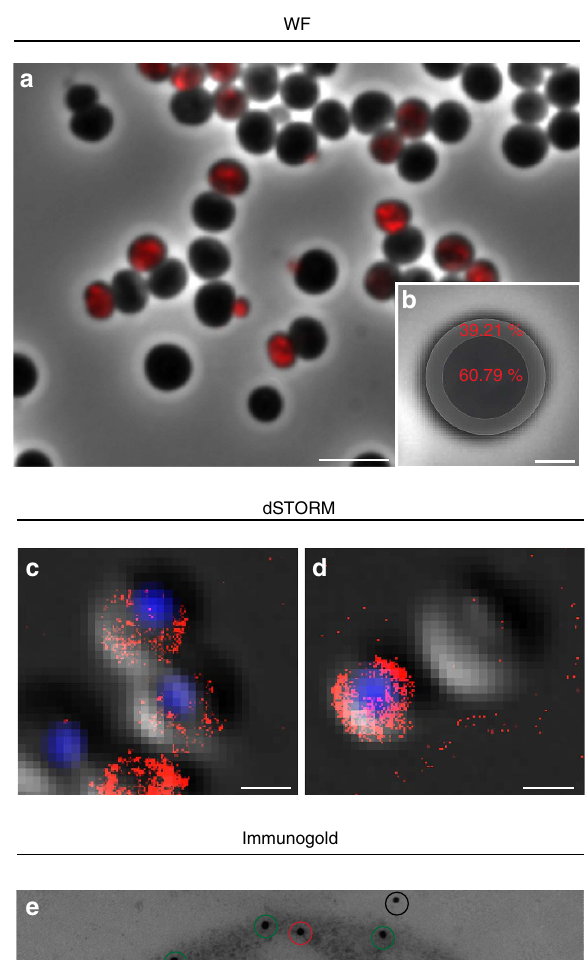
Figure 4 | The innermost planctomycetal membrane is energized. ( a ) Overlay of the wide field (WF) fluorescence signal from a representative ATPase localization experiment (red, anti-Na þ -F1F0-ATPase antibody) with the corresponding phase contrast (phaco) micrograph of G. obscuriglobus cells. Scale bar, 5 m m. ( b ) Among 50 analysed cells in five fields of view, 39.21% of the fluorescence signals were detected in the outer rim, as indicated by the schematic drawing overlaying a phaco micrograph of a single G. obscuriglobus cell. 60.79% of the signals were detected within the cytoplasmic area of cells ( t -test: P ¼ 0.0001, see Supplementary Fig. 5a,b for details). Scale bar, 1 m m. ( c , d ) Representative overlays of super-resolution direct stochastic optical reconstruction microscopic (dSTORM) ATPase localization experiments (red, anti-Na þ -F1F0-ATPase antibody) with the corresponding differential interference contrast micrograph of G. obscuriglobus cells. Scale bars, 1 m m. ( e ) Immunogold- labelling of the ATPase (black dots, anti-Na þ -F1F0-ATPase antibody) in high pressure-frozen and freeze-substituted G. obscuriglobus cells (see Supplementary Fig. 5c,d for detail). The micrograph shows four different localizations of gold particles which are either associated with the inner membrane (red circles), the outer membrane (green circles) or show non-specific localizations either within the cell (blue circles) or outside of the cell (black circles). Scale bar, 0.2 m